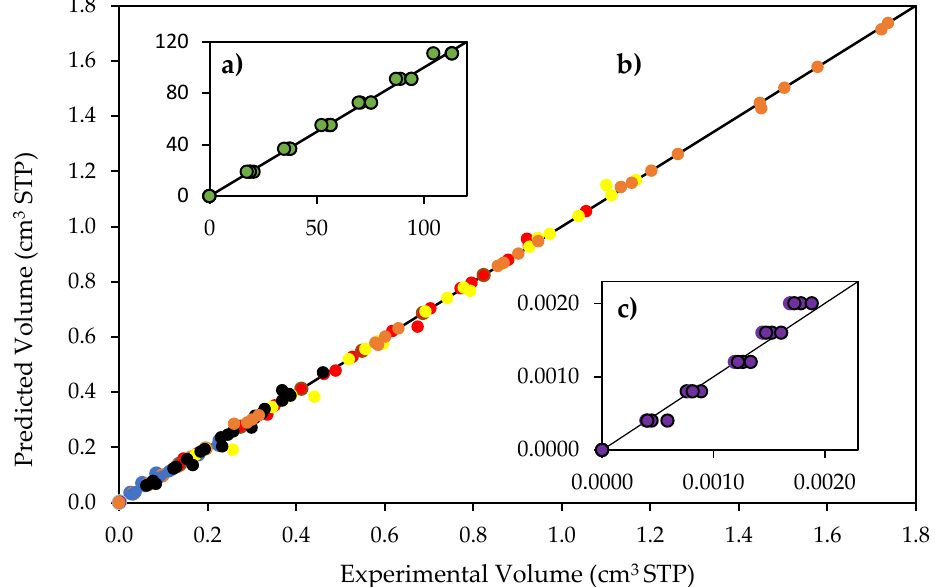
Figure 9. Reconciliation plot for predicted and experimentally observed species volumes. Notes: